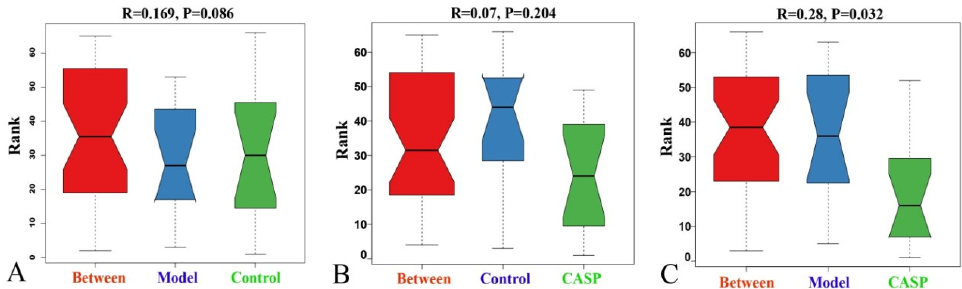
Figure 9. Anosim analysis of cecum content floras in each group. Note: ( A ) Anosim analysis diagram of the normal control group and the model group; ( B ) Anosim analysis diagram of the normal control group and the intervention group of CASP; ( C ) Anosim analysis diagram of the model group and the intervention group of CASP.